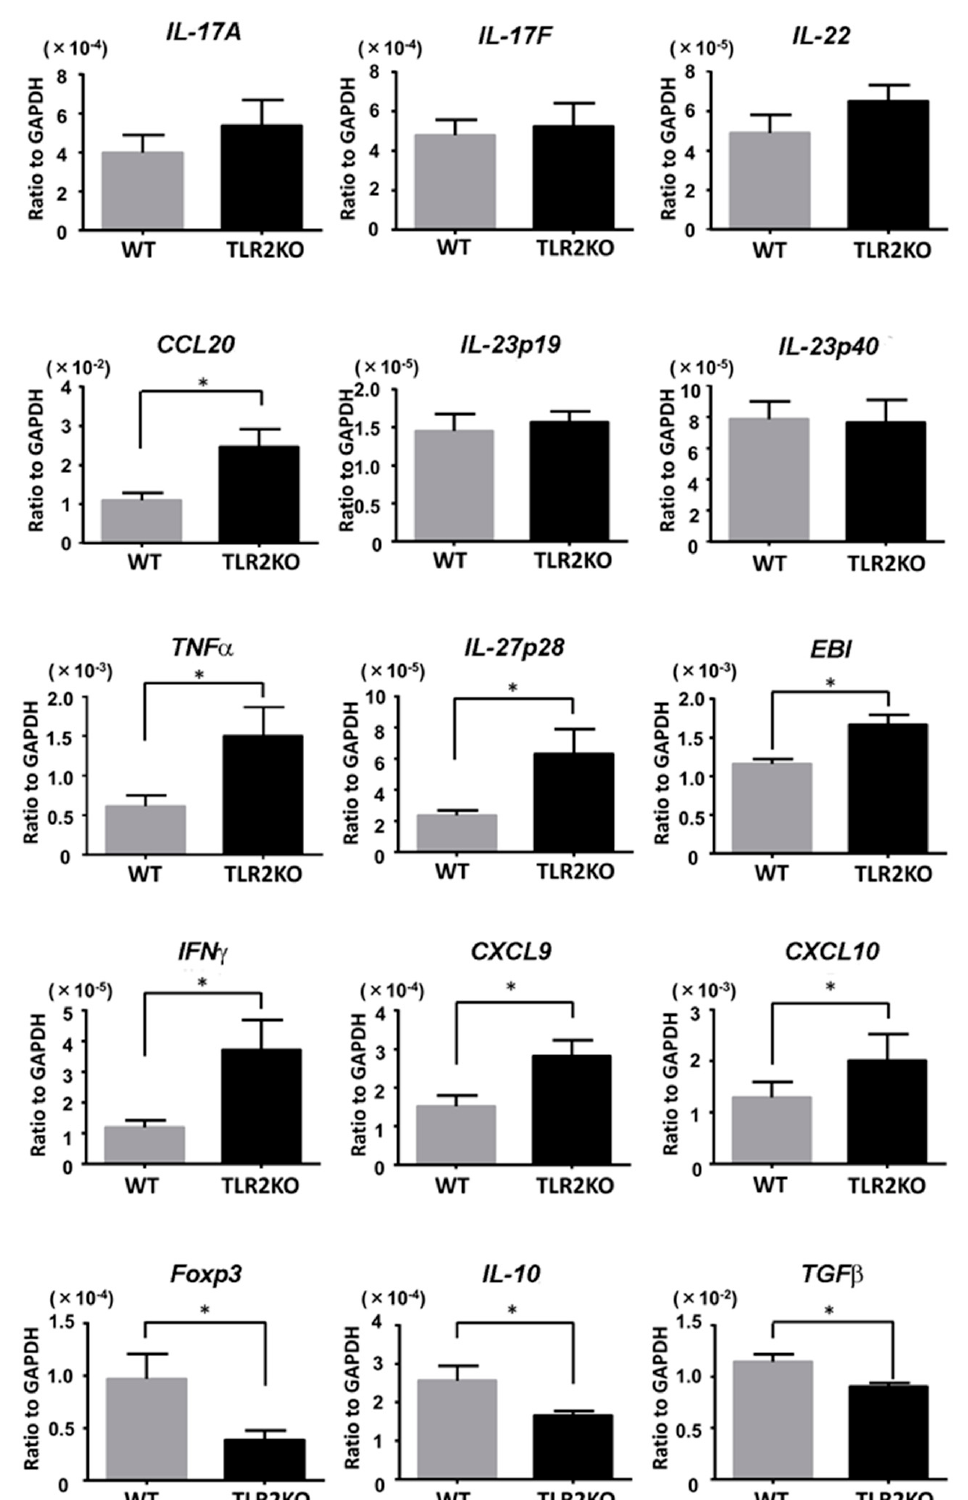
Figure 3. TLR2 deficiency increases Th1 cytokine mRNA levels and decreases Foxp3 and IL-10 levels. Wild-type (WT) and TLR2 knockout (TLR2 KO) mice were applied with imiquimod, and skin samples were taken 48 h after imiquimod application. Messenger RNA levels of the indicated cytokines and Foxp-3 were determined by quantitative RT-PCR. Data are obtained from duplicate samples from 12 mice in each group. Values are presented as mean ± SEM of three independent experiments. * p < 0.05. 2.3. TLR2 Deficiency Negatively Regulates Frequency of Tregs and IL-10 Expression in the Lymph Nodes To clarify whether TLR2 deficiency directly downregulates Tregs, we next performed flow cytometric analysis of regional lymph node cells 48 h after imiquimod application. TLR2 deficiency significantly decreased the frequency of CD4 and CD25 double-positive Tregs in the draining lymph nodes after imiquimod application (Figure 4A). The absolute numbers of Tregs on average were 7.2 × 10 5 and 5.0 × 10 5 in WT mice and TLR2 KO mice, respectively. The proportion of Foxp3 or IL-10- positive cells among the CD4-positive cells was significantly lower in TLR2 KO mice than that of WT